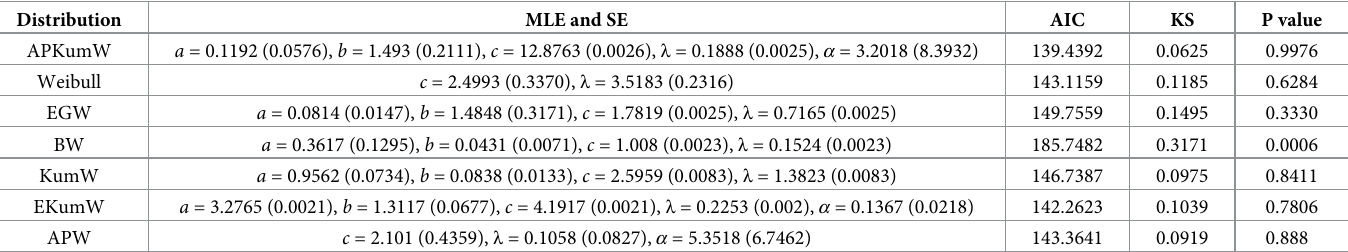
Table 5. MLEs, (SEs) for the parameters and associated goodness of fit statistics for the blood cancer data.